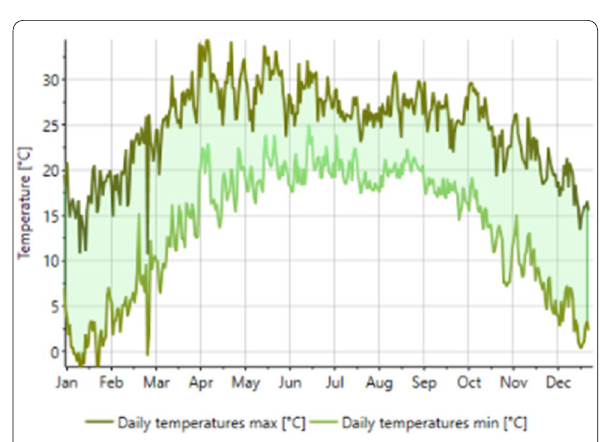
Fig. 6 The daily temperatures in